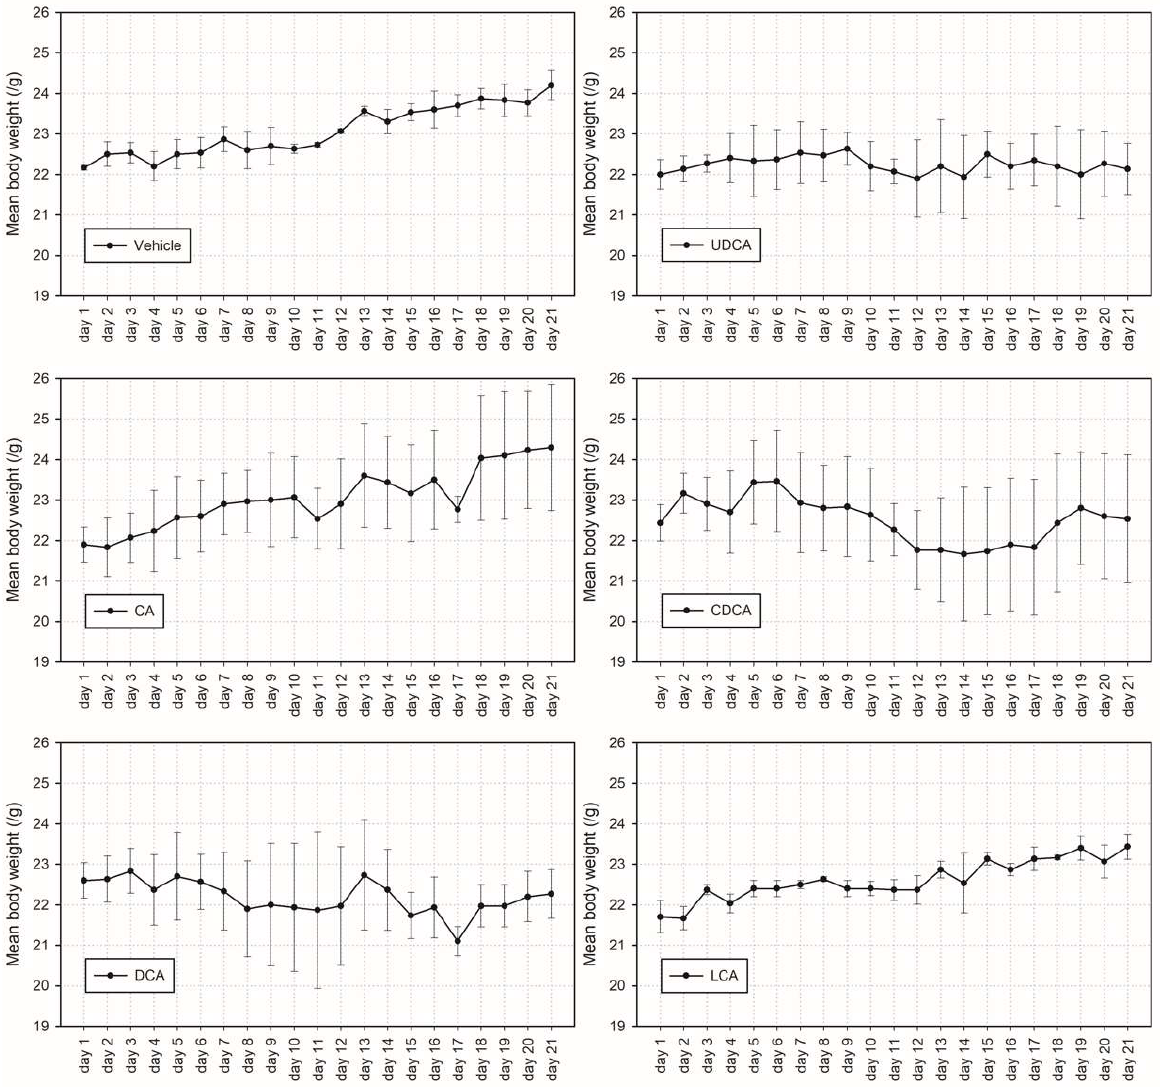
Figure 2. Average bodyweight of mice treated with different bile acids.